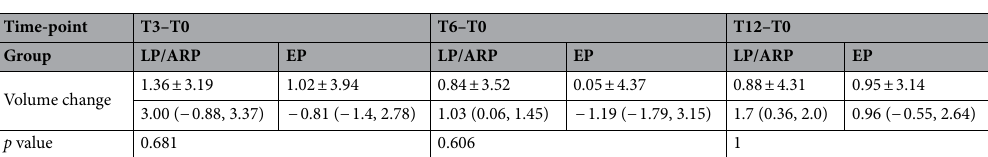
Table 3. Volume changes on a soft tissue level. Data are presented as a mean ± standard deviation, median (1st quartile, 3rd quartile). Positive and negative numbers indicate gain and loss, respectively. LP/ARP: late implant placement following 4 months of alveolar ridge preservation, EP: early implant placement. There were no statistically significant differences between the two groups.